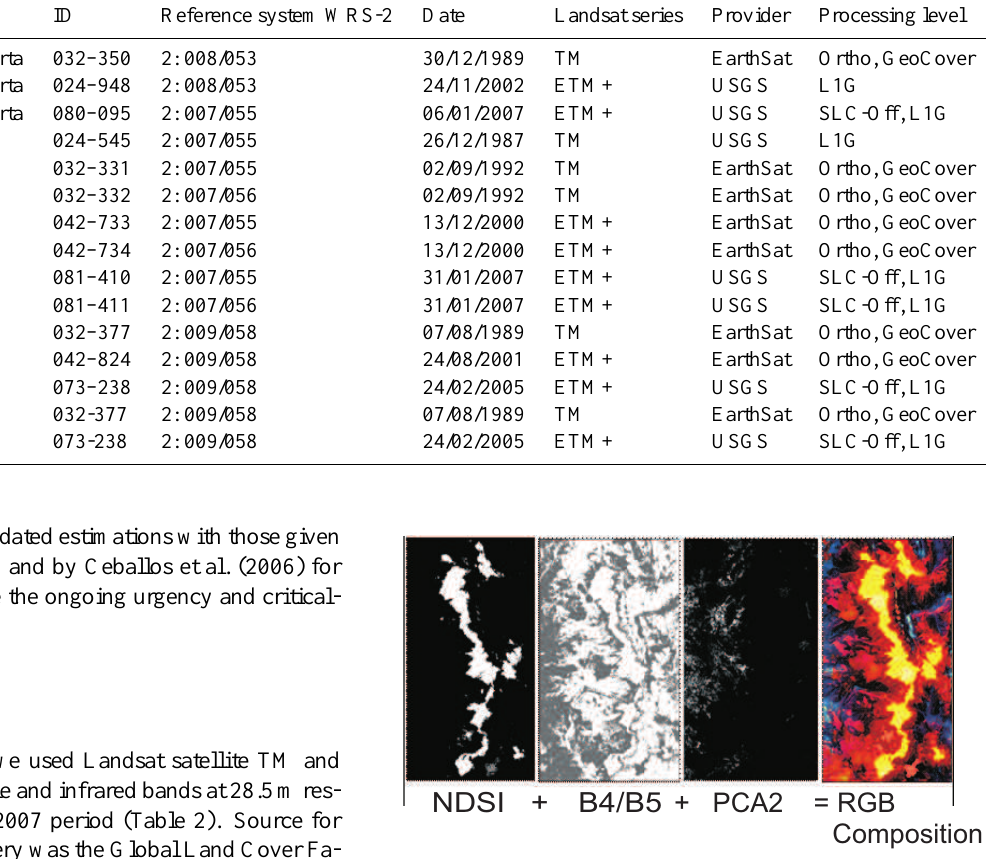
Fig. 4. Combination of images in the processing procedure. The Normalized Difference Snow Index (NDSI), the ratio between bands 4 and 5, and the Principal Component Analysis No. 2 in the red (R), green (G), and blue (B), channels, are combined together to produce an improved RGB